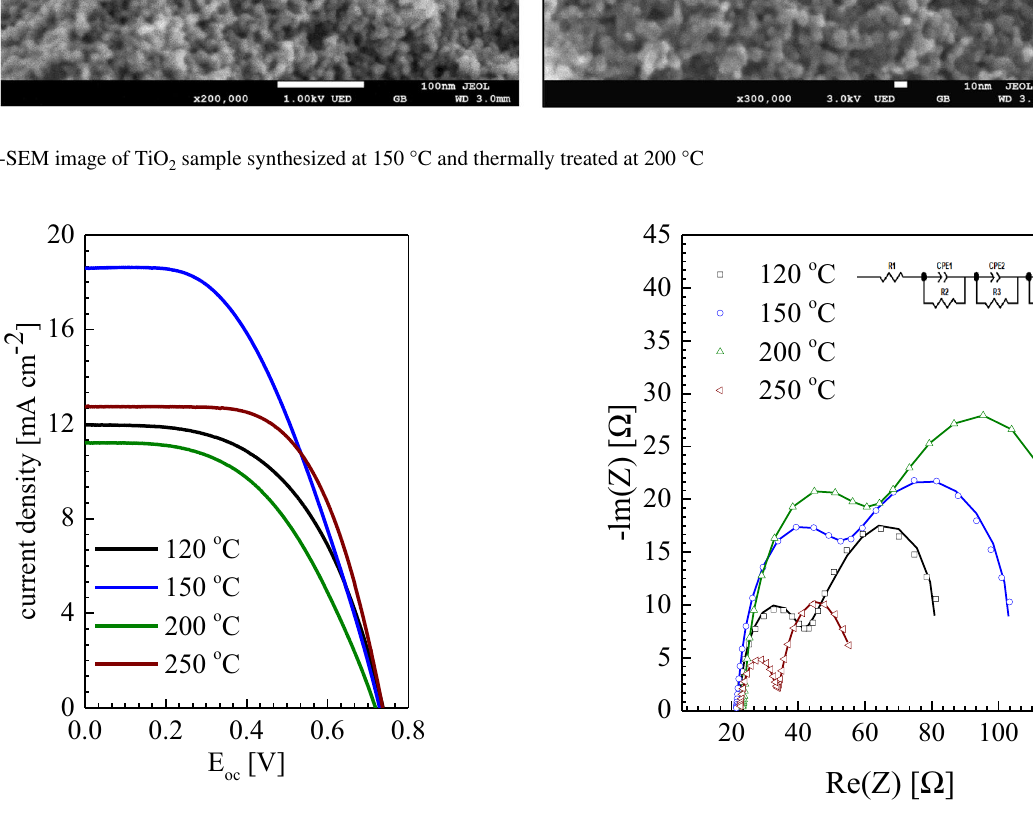
Fig. 5 J – V measurement of dye-sensitized solar cells with mesoporous TiO 2 samples Table 3 Photovoltaic parameters of DSSC fabricated with the TiO samples Sample